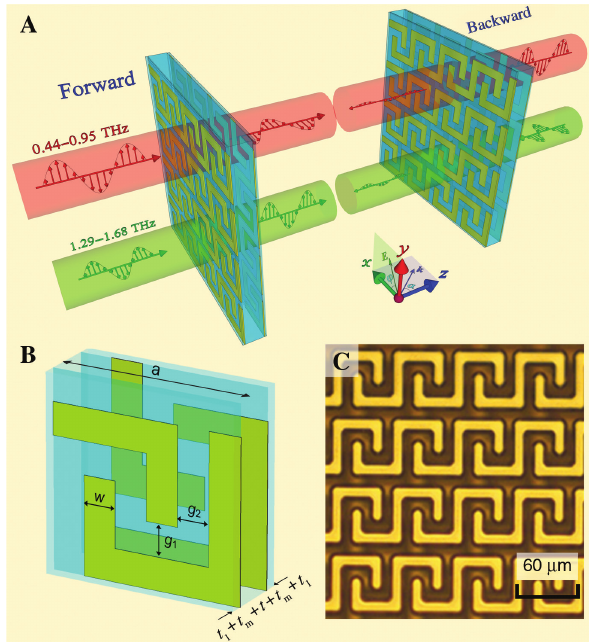
Figure 1: Structure and schematics of asymmetric transmission effect. (A) Artistic rendering of the dichroic asymmetric transmission for the proposed chiral metamaterial. The normally forward incident x and y polarized waves can be transmitted and converted into their cross-polarization in two adjacent frequency bands, whereas they are blocked in the reversed direction. The polarization angle ϕ and incident angle α are marked in the inset. (B) Stereogram of a unit cell in the proposed metamaterial. Two 90 ° twisted and mirrored chained S-shaped aluminum layers are separated by a polyimide layer. (C) Optical microscope image of the fabricated sample.